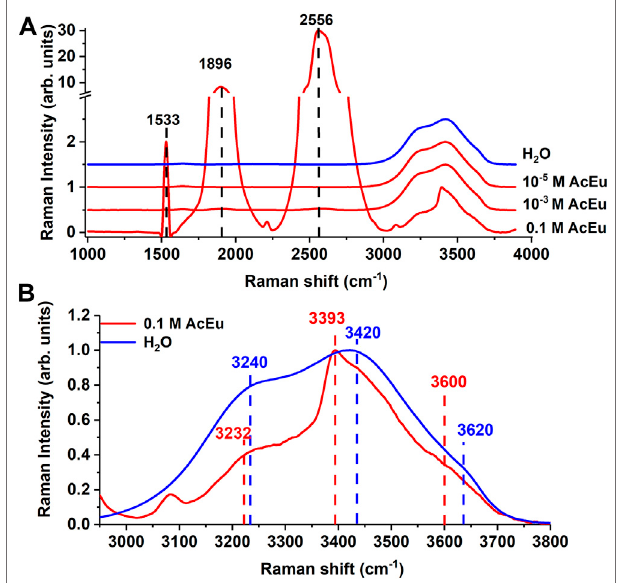
FIGURE 1 | (A) Raman spectra of AcEu solutions (red) at different concentrations and water (blue). The spectra are shifted along the ordinate axis. (B) an enlarged section of the spectra in the 3000 – 3800 cm − 1 region. The spectra overlap each other.